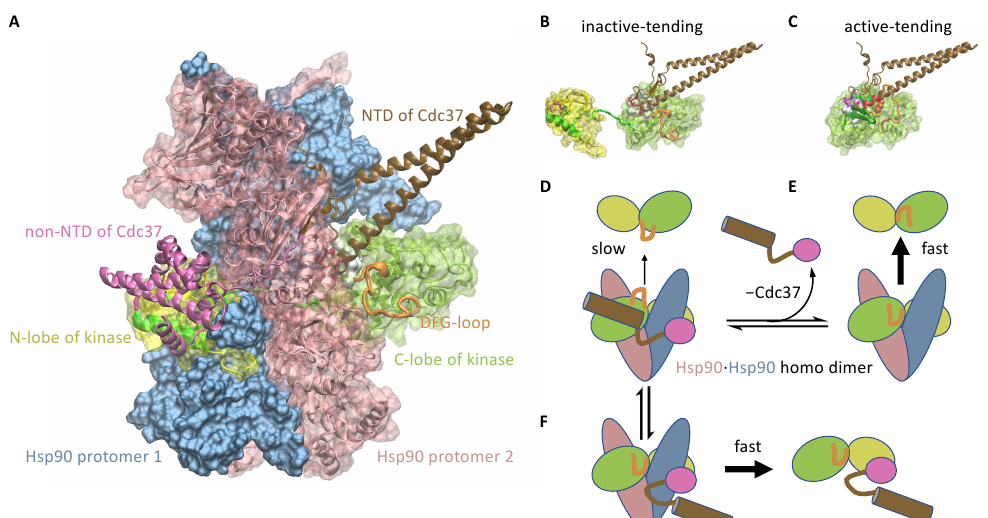
Figure 2. Cochaperone Cdc37 enables a client kinase in different conformations to unbind from Hsp90 at different rates. ( A ) the Hsp90-Cdk4-Cdc37 complex structure (PDB: 5FWM). The closed Hsp90 homo dimer clamps a partially unfolded Cdk4 kinase, and Cdc37 simultaneously binds to Cdk4 and Hsp90; ( B ) Cdc37 can bind to the kinase in the inactive-tending conformation; ( C ) steric clashes prevent Cdc37 from binding to the kinase in the active-tending conformation, due to its DFG-loop configuration and other conformational features; ( D ) Cdc37 helps to retain an inactive- tending kinase molecule inside the open Hsp90, resulting in slow unbinding of the kinase from the Hsp90. The bipartite interaction by NTD and CTD of Cdc37 with the kinase may result in the encirclement of a Hsp90 protomer by the Cdc37-kinase complex, preventing the latter from slipping off Hsp90. ( E ) Without Cdc37, an active-tending kinase molecule unbinds rapidly from the open Hsp90. ( F ) Alternatively, the loss of the interaction between the NTD of Cdc37 and the C-lobe of an active-tending kinase breaks the bipartite interaction between Cdc37 and the kinase, resulting in the release of the Cdc37-kinase complex from